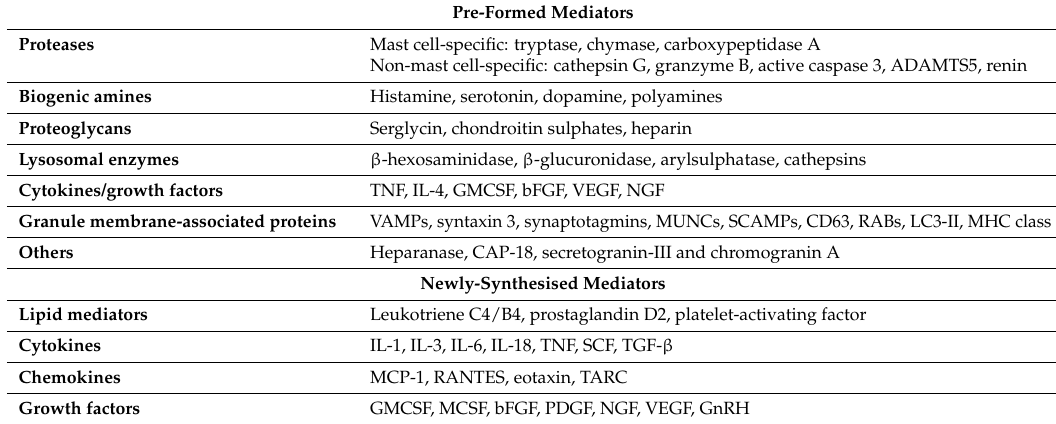
Table 1. Mast cell